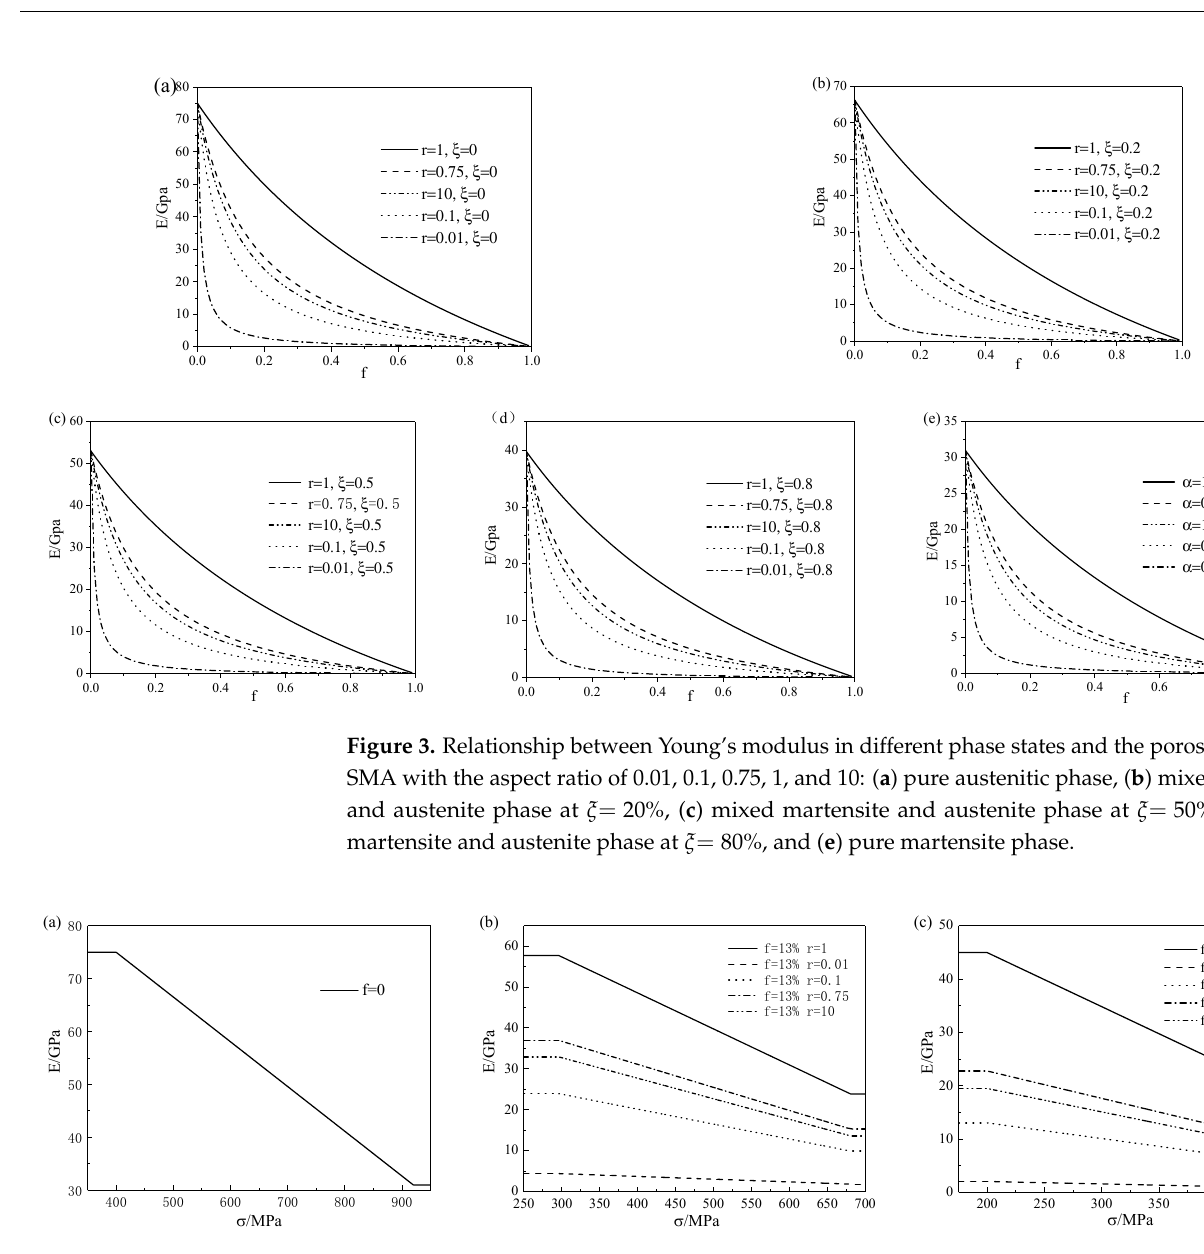
Figure 4. Comparison of the relationship between the Young’s modulus of five types of porous SMA with effective stress at different porosities of ( a ) 0, ( b ) 13%, and ( c ) 25%.